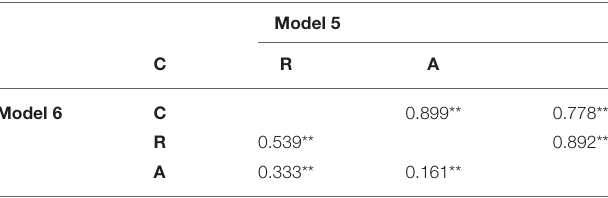
TABLE 3 | Standardized factor correlations for the ICM-CFA solutions with 3 first-order factors (above the diagonal) and the corresponding ESEM solutions (below the